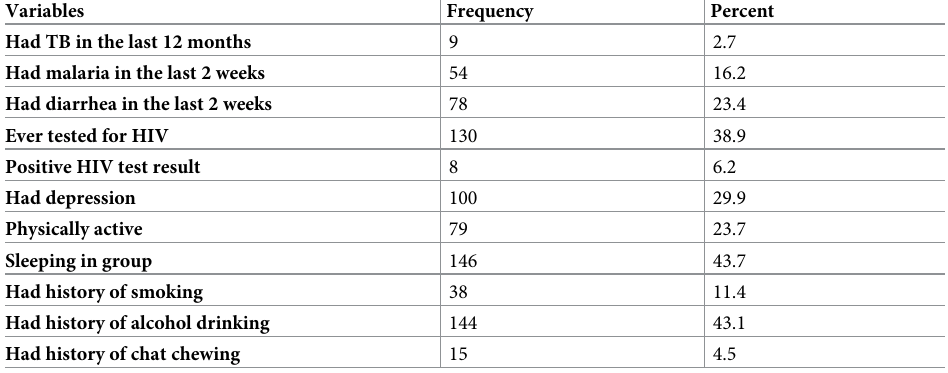
Table 2. Medical, behavioral and environmental characteristics of incarcerated people in Mizan prison institute, southwest Ethiopia, 2020 (n =